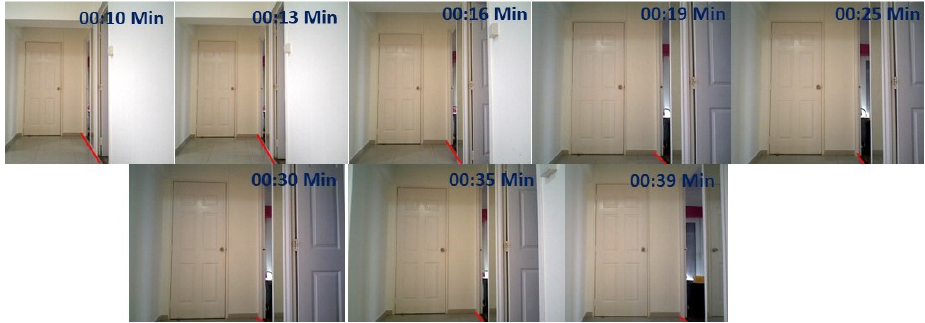
Figure 20. Series of image from the hsr robot during the trial with embedded time scenario